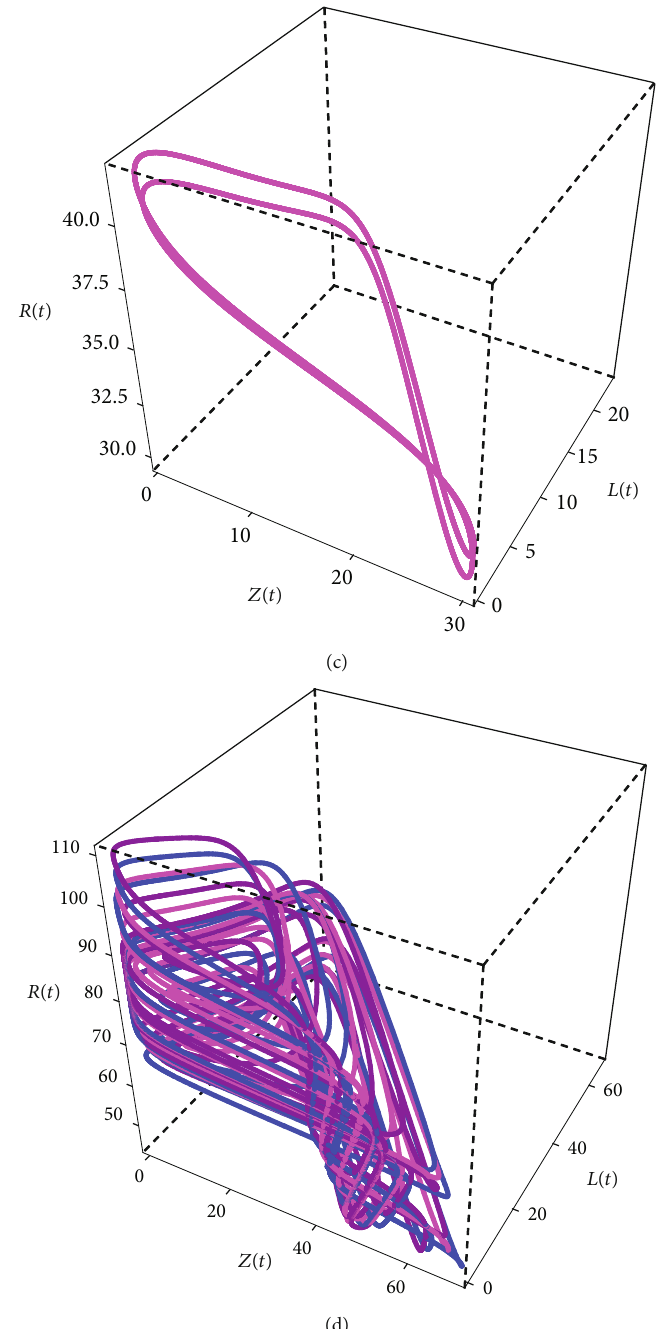
= 0 : 005 , (b) γ = 0 : 0095 , (c) γ = 0 : 075 , and (d) γ = 0 : 16 2 2 2 2